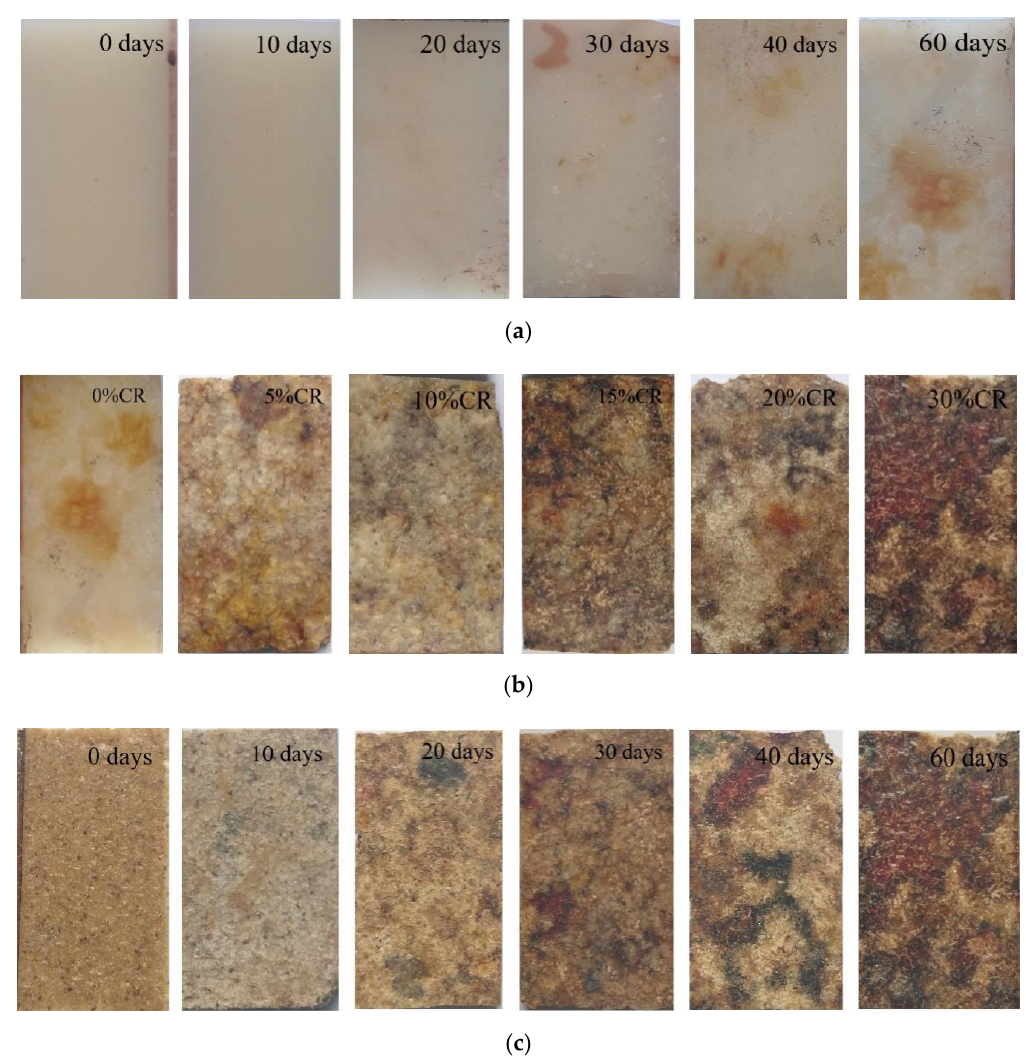
Figure 7. Surface morphologies after disintegration. ( a ) Pure PBS; ( b ) different cassava residue contents; ( c ) 30% cassava residue/PBS.